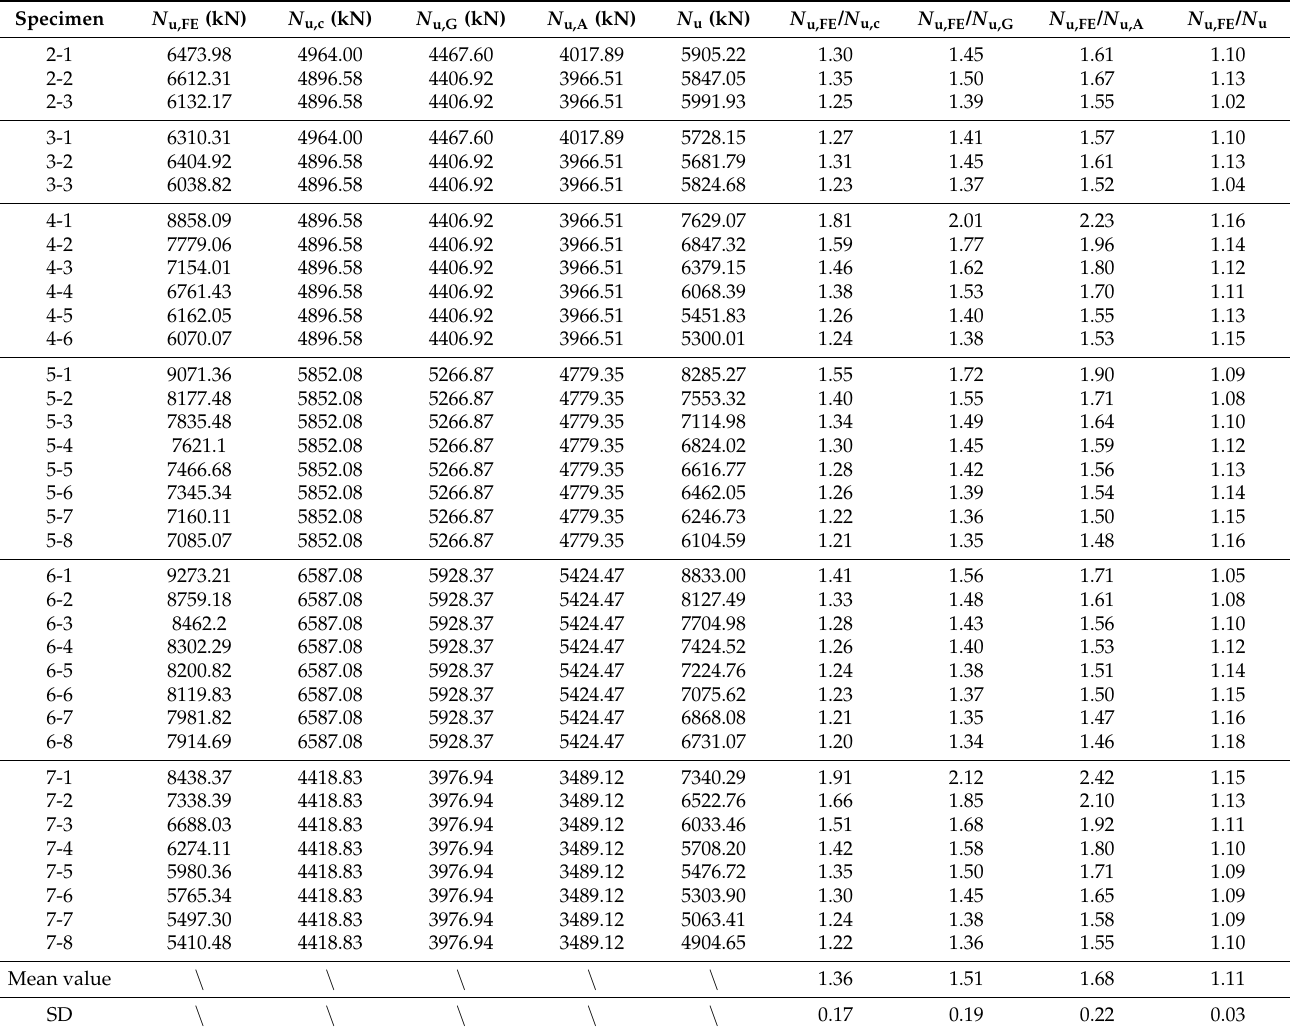
Table 4. Comparison of axial compression